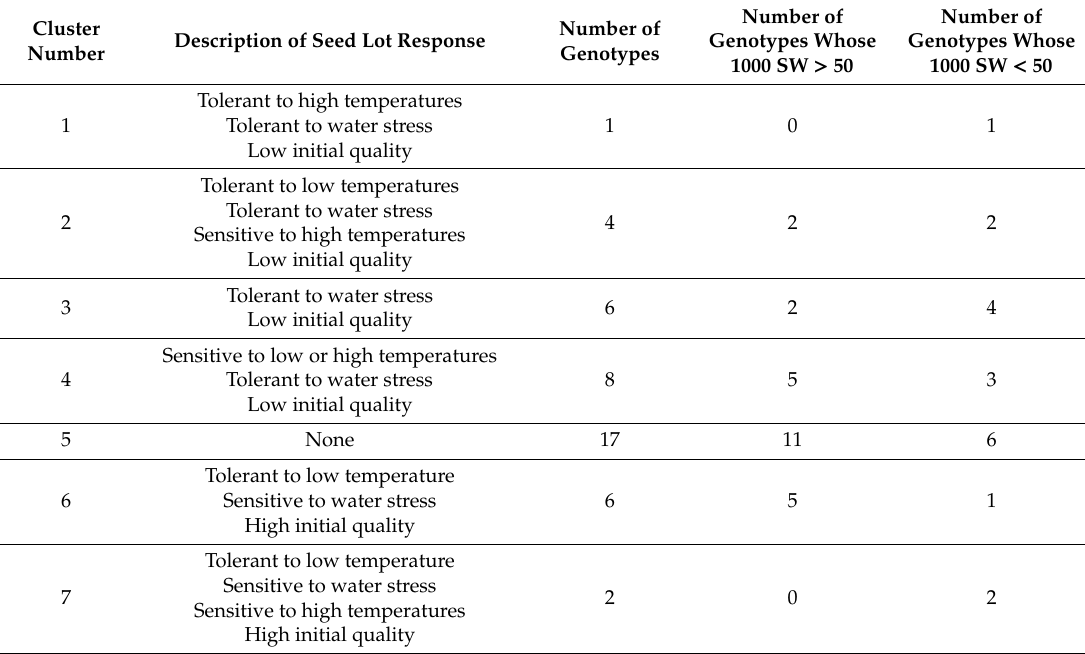
Table 3. Description of genotypes belonging to the di ff erent clusters; 1000 SW corresponds to the weight of 1000 seeds (g).